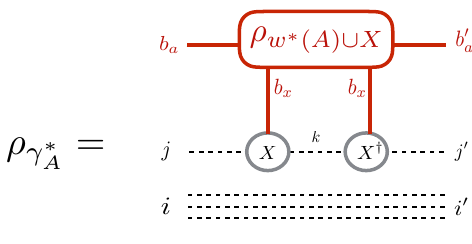
Figure 9. The state (cid:26) (cid:13) (cid:3) A used to compute S A